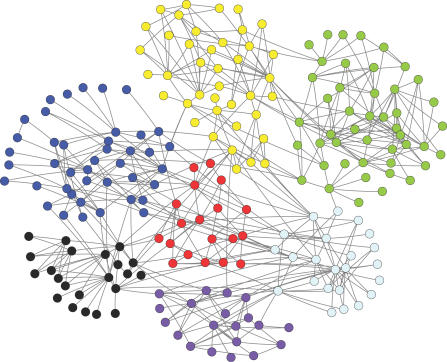
A Random Network Generated by Gene Duplication Followed by Subfunctionalization Shows High Modularity (Modularity = 0.6717, Scaled Modularity = 29)Different colors represent different modules identified by Guimera and Amaral's algorithm [28].